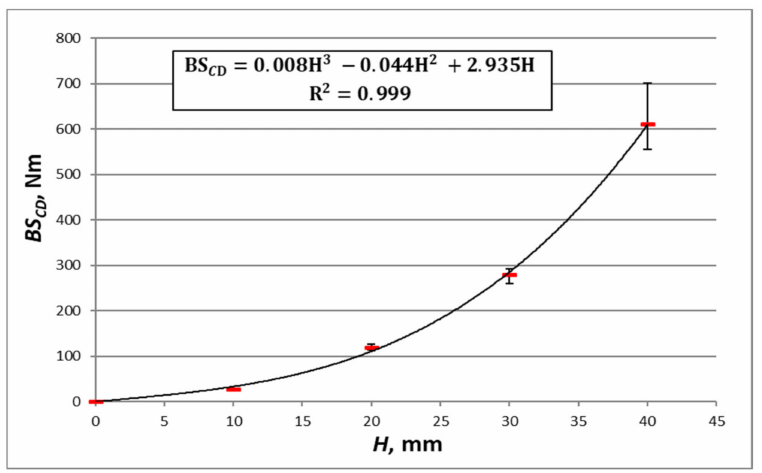
Figure 13. Measurements of BS CD boards TL200/FL140/TL200 with core cell size of D = 15 mm and different